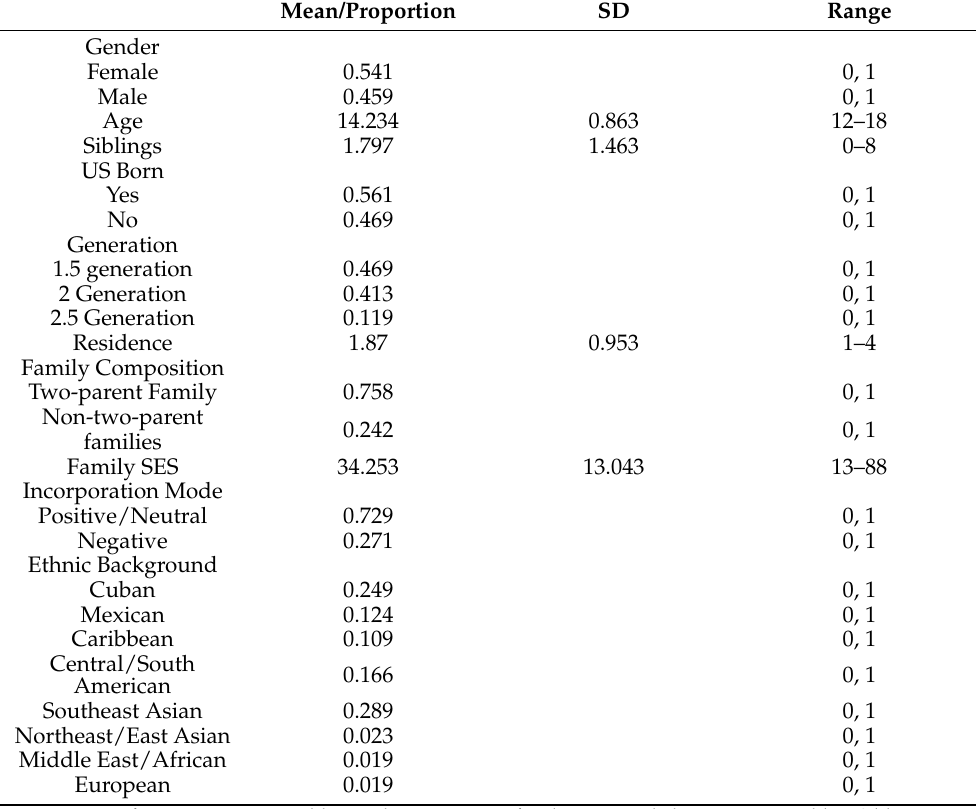
Table 2. Demographics of Immigrant Children of CILS, n =